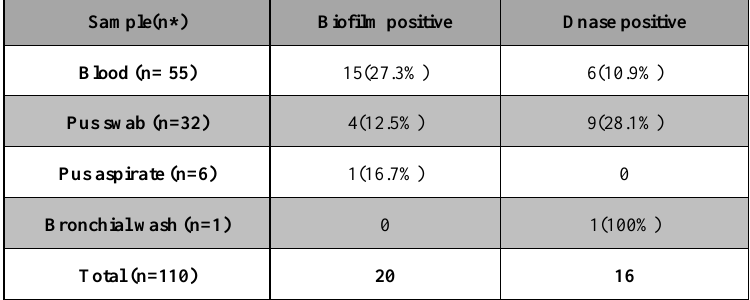
Table 3. Distribution of virulence factors in various clinical samples.